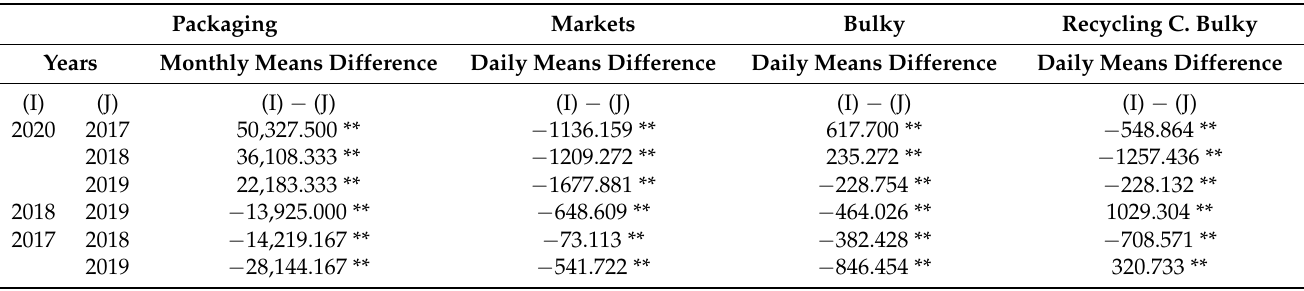
Table 4. Significant differences in packaging, markets, bulky and recycling centre bulky